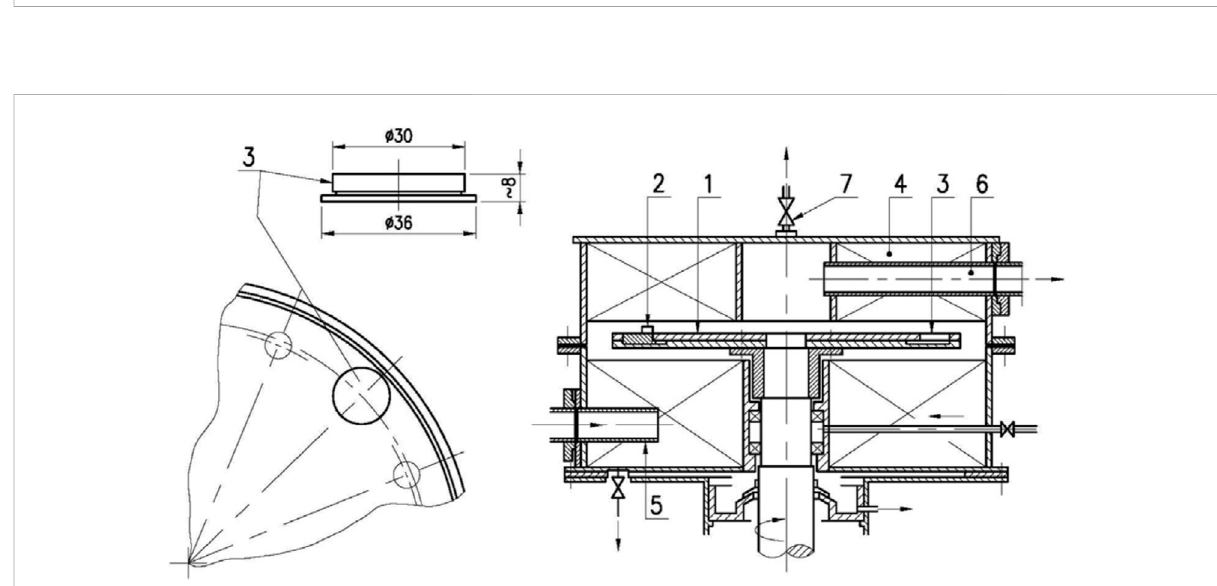
FIGURE 4 Rotatingdiskdevice(StellerandGire ń ,2015)attheIMPPANlabinGdansk,Poland.1-disk;2-cavitator(pin);3-specimen;4-stagnatorvane;5,6- liquid inlet, outlet; 7-de-aerating